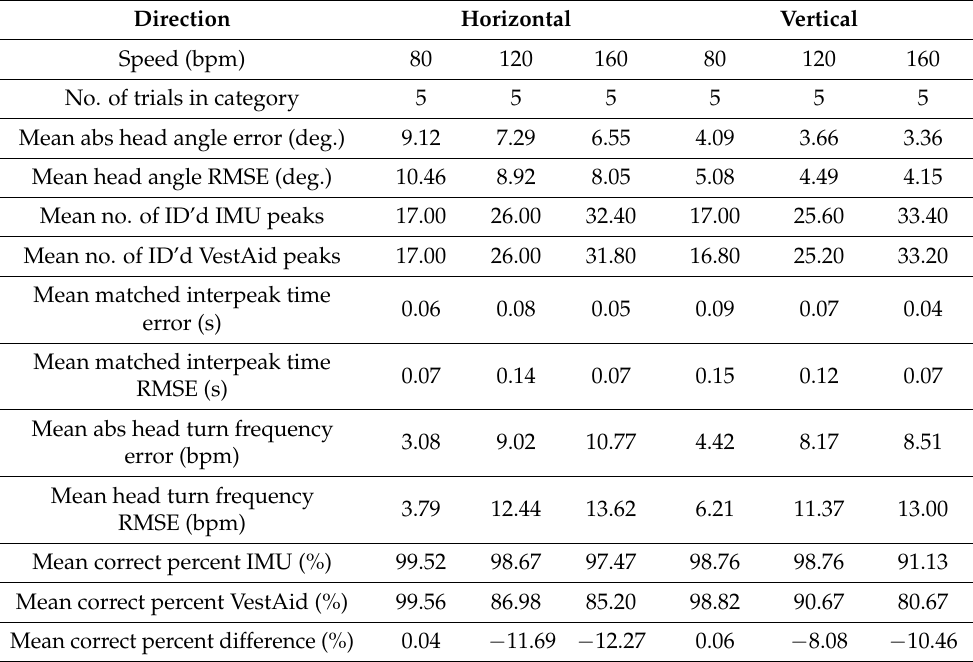
Table 5. Overview of temporal and spatial error metrics of the VestAid system. Direction Horizontal